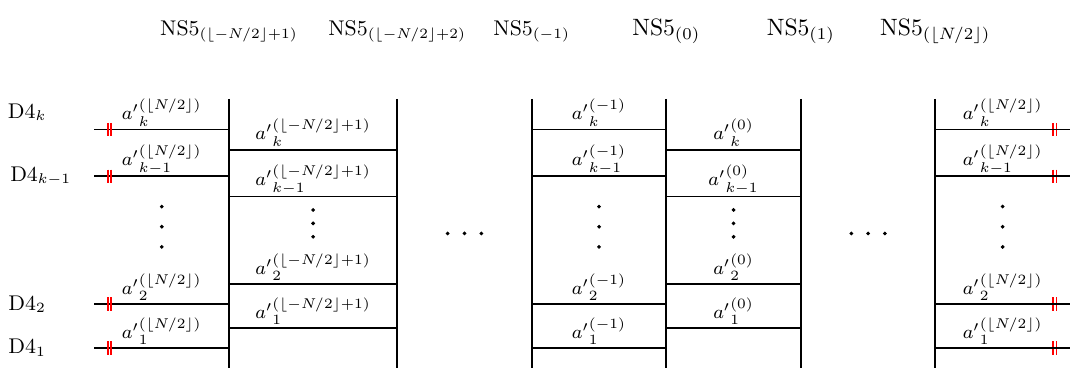
Figure 1 . The brane set up for the U( k ) N circular-quiver theory. The vertical lines represent NS5 branes while the horizontal lines represent D4 branes. The cyclic identification of the end points is indicated by the double red line on the D4